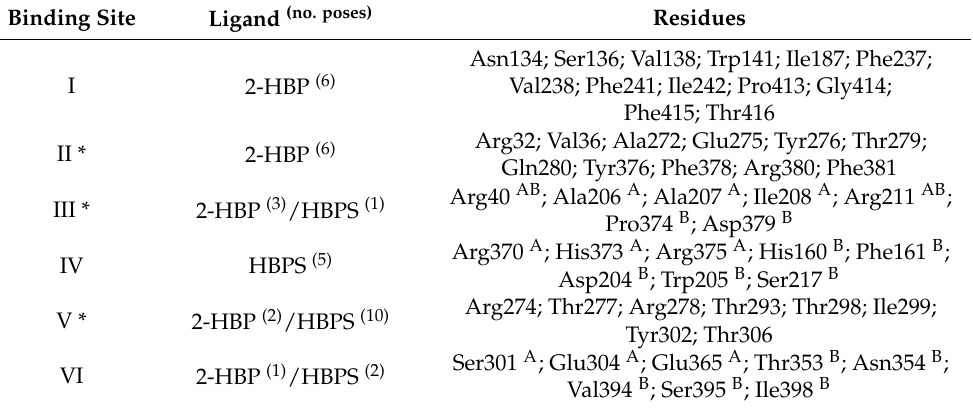
Table 1. Binding sites that were identified after an analysis of the docking assays with 2-HBP and HBPS. The number of poses found for each ligand at each binding site is indicated in superscript. Whenever the binding site is composed of residues from the two monomers, the corresponding chains are identified with A/B superscripts.